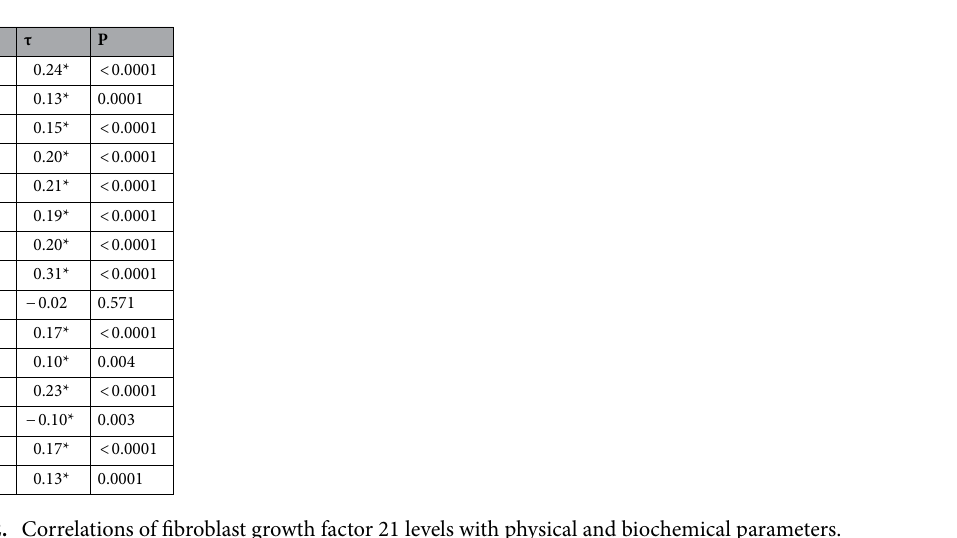
Table 2. Correlations of fibroblast growth factor 21 levels with physical and biochemical parameters. *P < 0.005. Abbreviations are as in Table